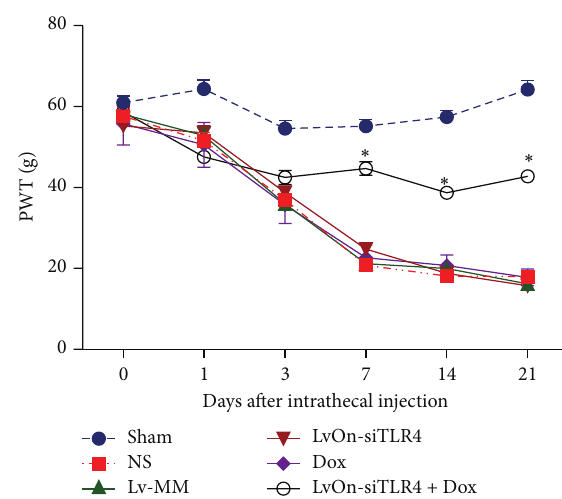
Figure 1: Impact of LvOn-siTLR4 with Dox on PWT in bone cancer pain rats. The bone cancer pain was set up by the injection of Walker 256 cells into the legs of rats. After cancer cells injection, rats received intrathecal administration of the virus on the 4th day.